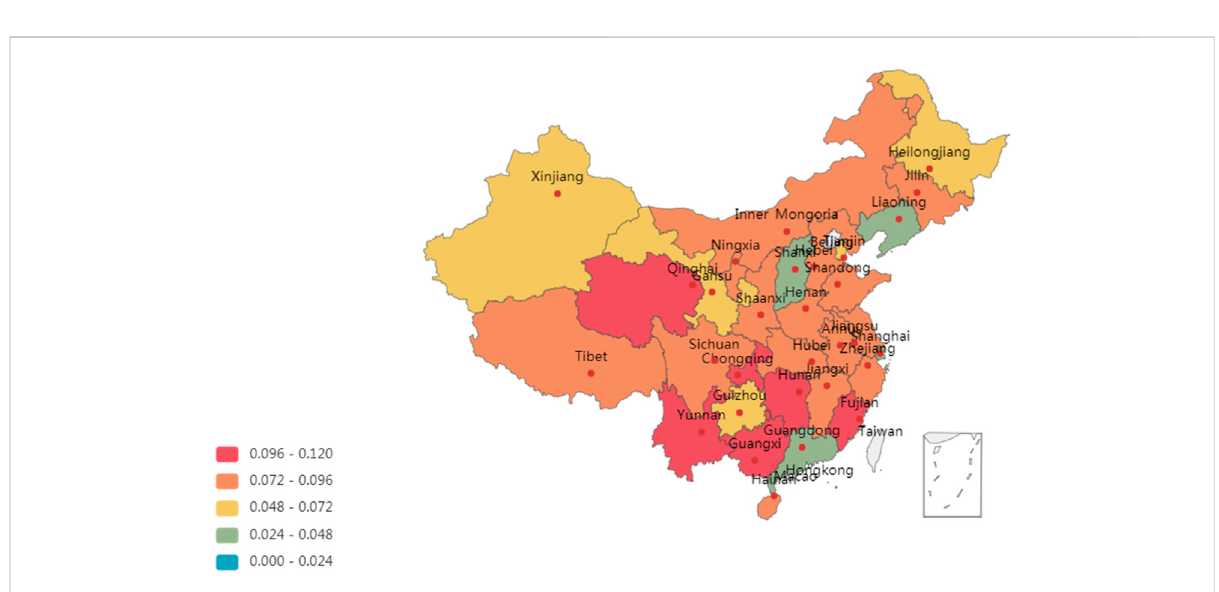
FIGURE 6 National green total factor productivity of service industry in